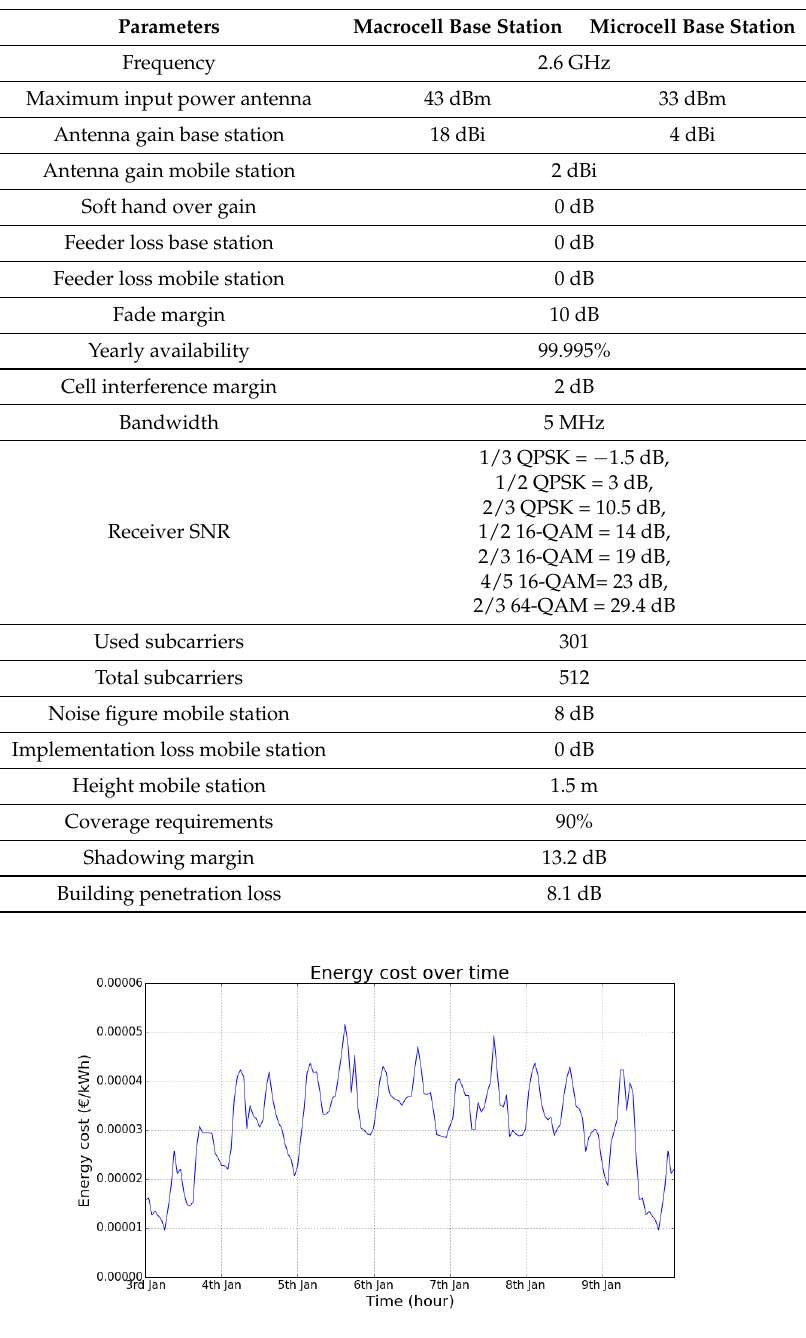
Table 1. Link budget parameters for the LTE-A macrocell and microcell base station.